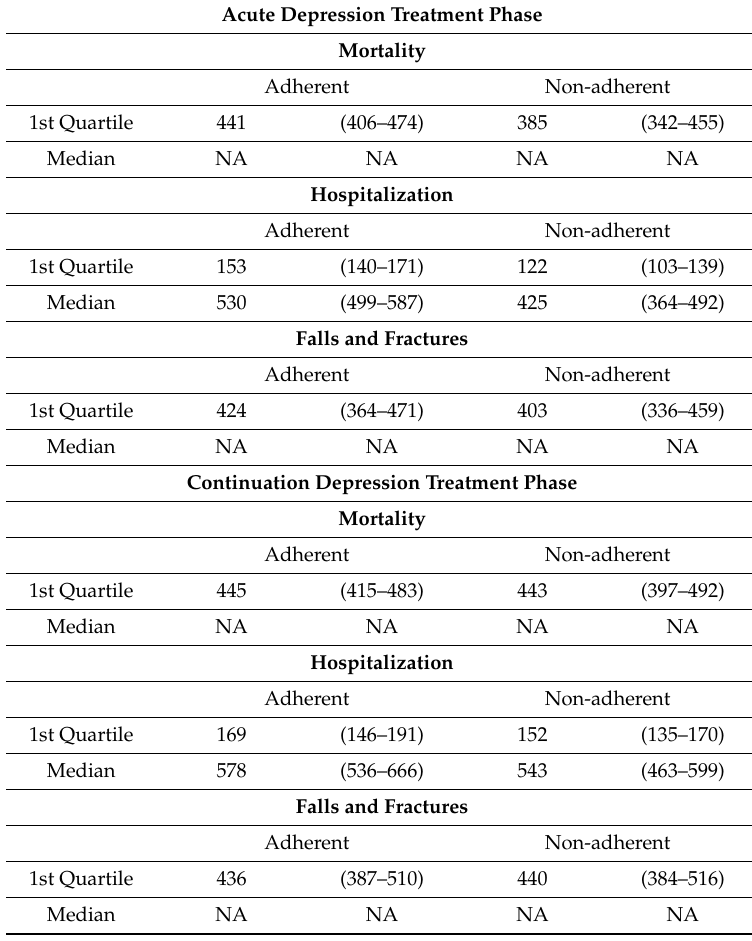
Table 4. Median and first quartile survival times (95% CI) in days for all-cause mortality and time-to-hospitalization and falls and fractures (95% CI) in